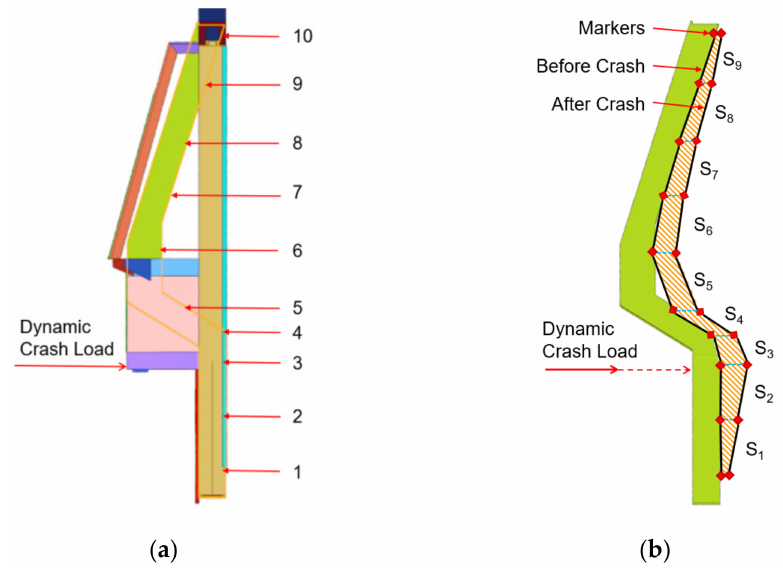
Figure 5. Longitudinal deformation details: ( a ) location of markers; ( b ) S_In sketch.